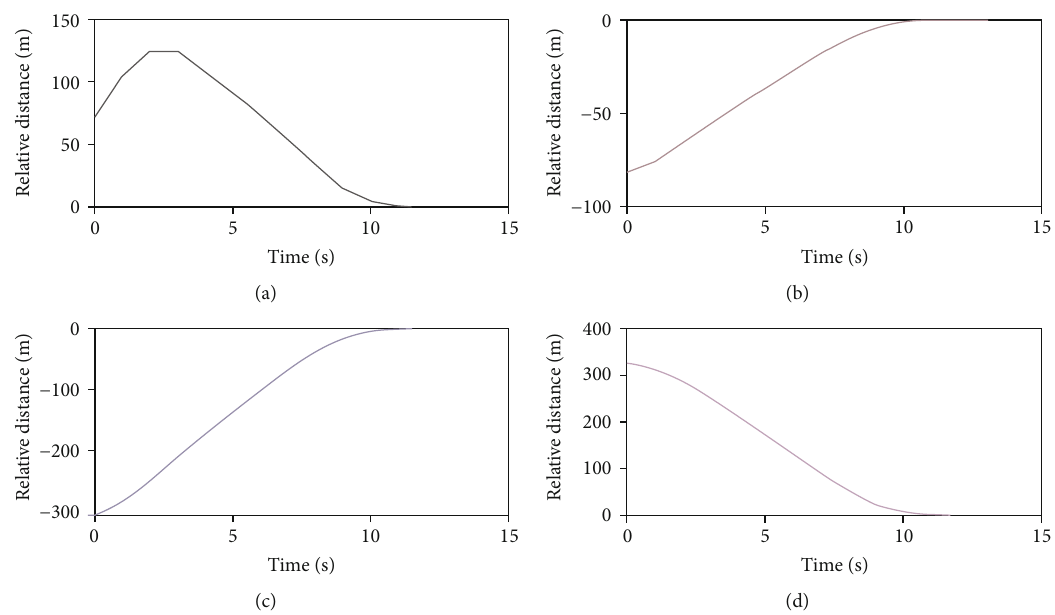
Figure 13: The distance between the spacecraft and the goal: (a) distance in the X direction, (b) distance in the Y direction, (c) distance in the Z direction, and (d) total